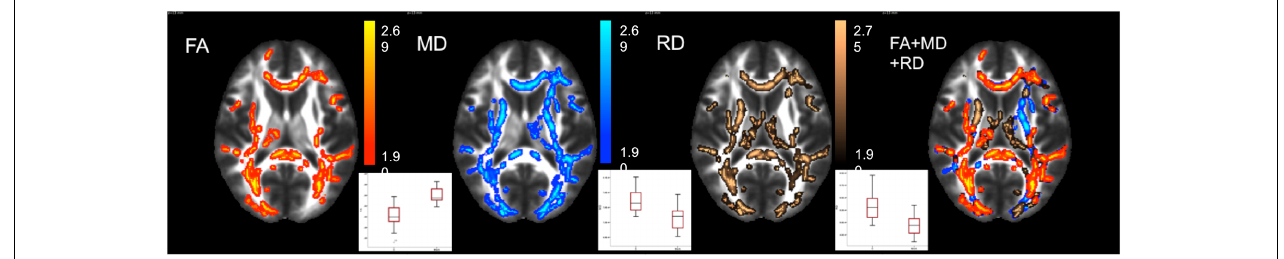
FIGURE 1 | White matter abnormalities in MwA compared to controls. Axial slices show the diffusivity parameter changes from TBSS. The FA increased, mean and radial diffusivity decreased in migraine aura compared to controls. Axial diffusivity showed no alteration. The affected areas are mainly overlapping (see in 4th brain). The color bar shows the z-scores of the corrected p -values. The boxplot shows the MD parameters depicted from the affected areas, the central mark is the median and the boxes represent the 25 and 75% percentiles.